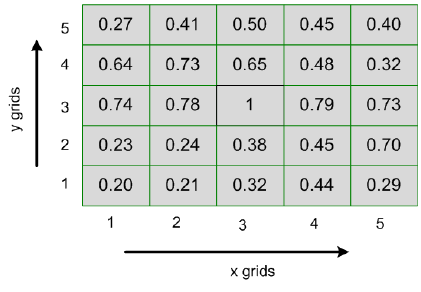
Figure 7. Spatial correlation.